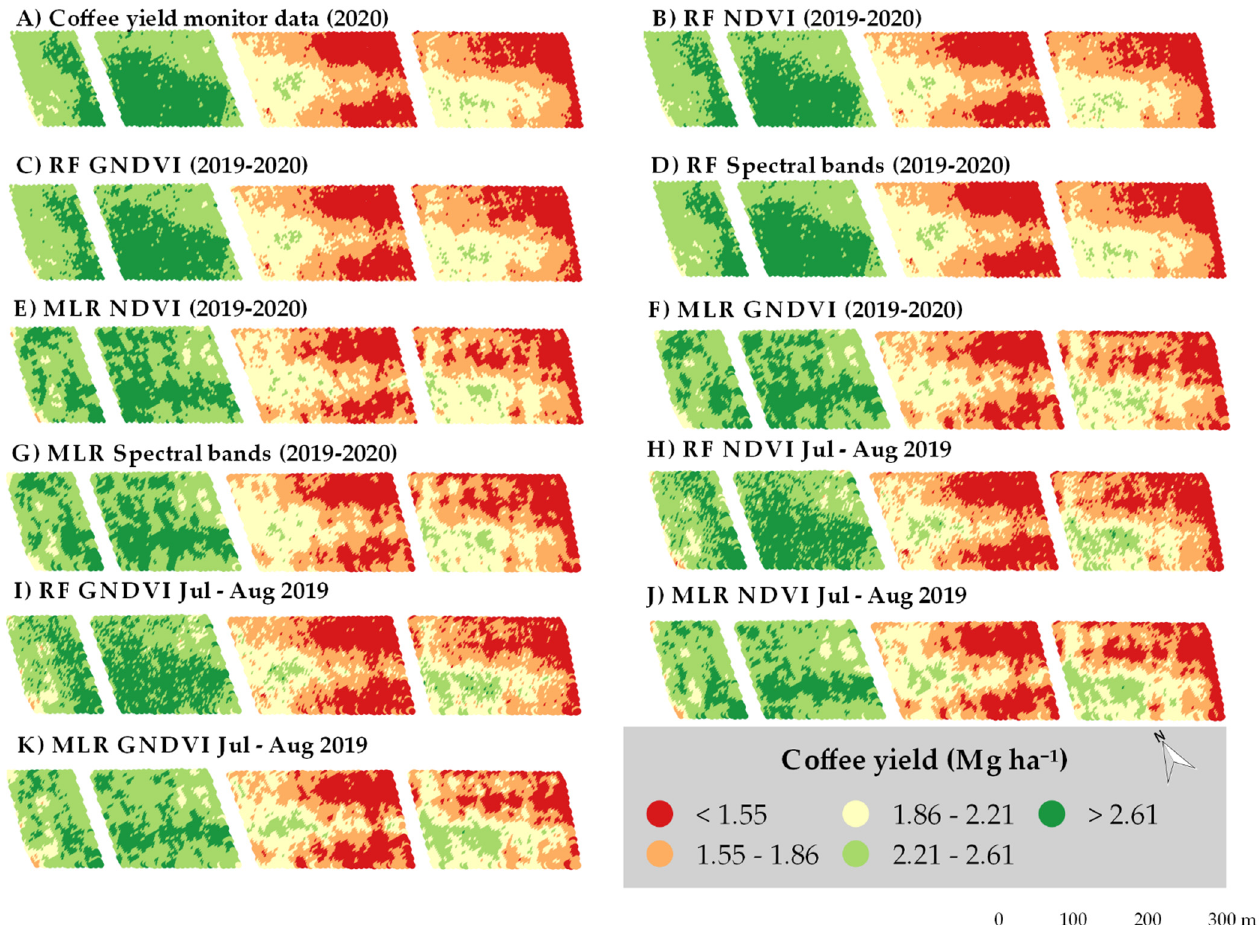
Figure 5. Coffee yield (Mg ha − 1 ) maps generate for harvest 2 (2019–2020) from ( A ) Coffee monitor data/2020; ( B ) RF regression model based on spectral bands/2019/2020, ( C ) RF regression based on NDVI/2019/2020, ( D ) RF regression based on GNDVI/2019/2020, ( E ) MLR based on spectral bands/2019/2020, ( F ) MLR based on NDVI/2019/2020, ( G ) MLR based on GNDVI/2019/2020, ( H ) RF regression based on NDVI obtained in July (jul) and August (ago)/2019, ( I ) RF regression based on GNDVI obtained from July and August/2019, ( J ) MLR based on NDVI obtained from July and August/2019; and ( K ) MLR based on GNDVI obtained from July and August/2019.